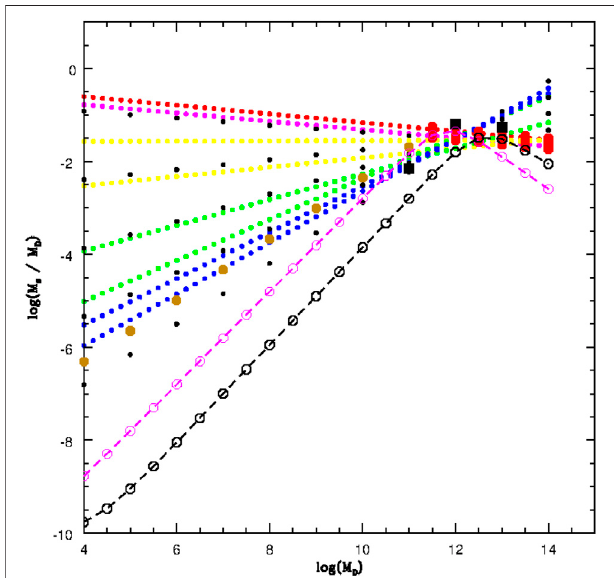
FIGURE 8 | The relations between M s / M D and M D at different redshifts for different theoretical models (all masses are in solar units). The colored dotted lines correspond to eight values of the redshift z (cid:1) 0 and z (cid:1) 0.2 (top, red), z (cid:1) 0.6, z (cid:1) 1.0 (intermediate, yellow), z (cid:1) 1.6 and z (cid:1) 2.2 (intermediate, green), z (cid:1) 3 and z (cid:1) 4 (bottom, blue). The black dots are the values resulting by Eq. 28 at varying log M D (from 4 to 14 in steps of 1) and redshift z (from 0 to 4 in steps of 1), respectively. The large red and golden circlesarethecombinationof Eqs29 , 30 .Theopenmagenta( z (cid:1) 0)anddark- olive( z (cid:1) 3.95) open circles are therelations M s / M D vs M D at different redshifts according to Girelli et al. (2020). Note that all relations agree at logM D ≃ 12, whiletheybadlydisagreeatlowervaluesof M D .Reproduced fromChiosietal.